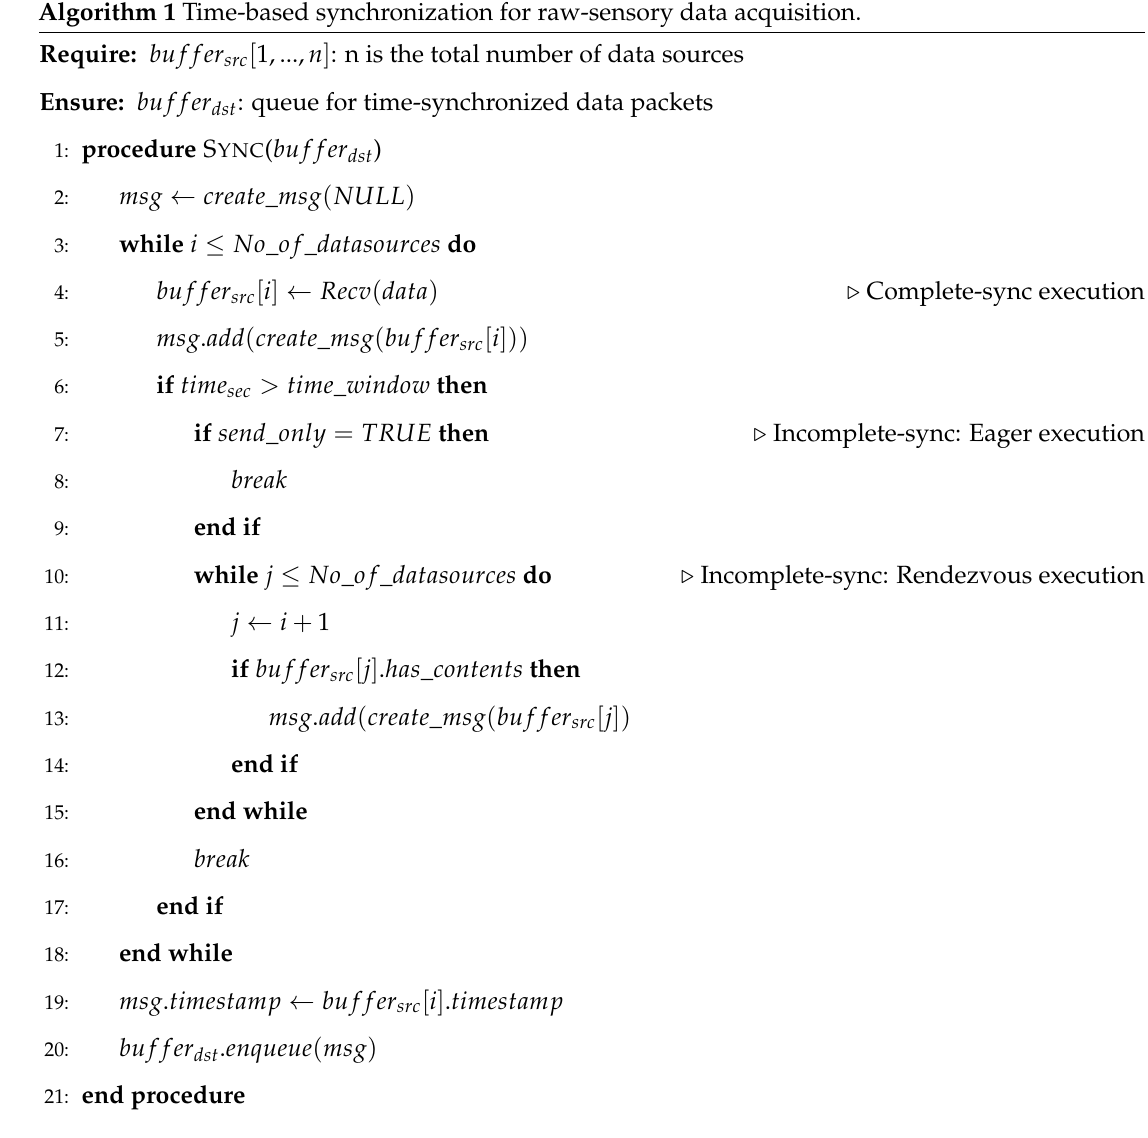
Algorithm 1 Time-based synchronization for raw-sensory data